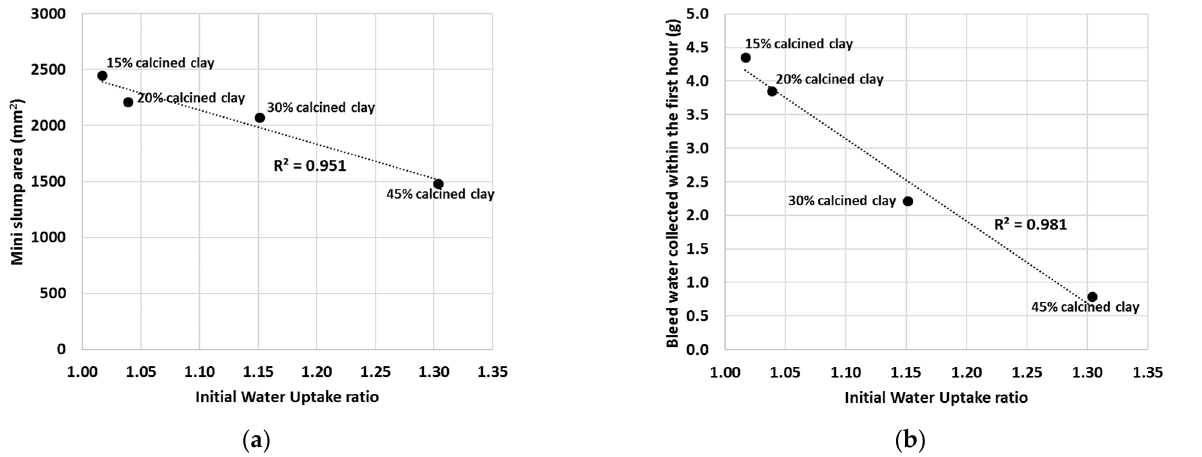
Figure 11. Linear regression between the mini slump values ( a ) or mini bleed values ( b ) and the IWU ratios of calcined clay blends. (Note that the linear relationship is obtained at calcined clay percentages between 15% and 45%.).